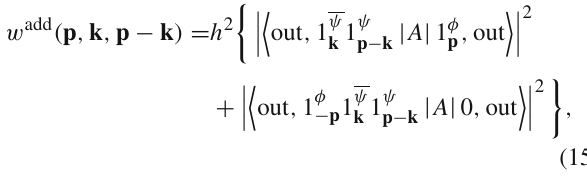
combined effect of these two diagrams is to be